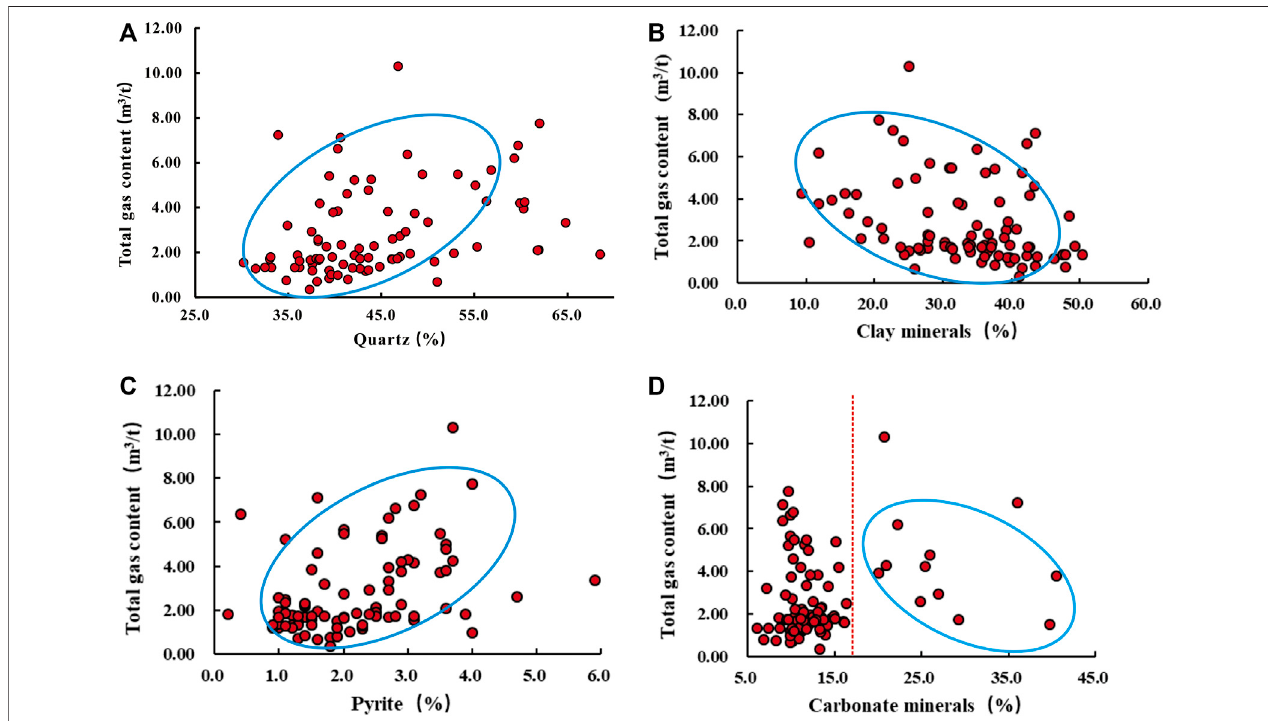
FIGURE 8 | Relationship between the minerals and the total gas contents of the Longmaxi Formation shale in the Changning area. (A) Relationship between the quartz and the total gas contents; (B) Relationship between the clay minerals and the total gas contents; (C) Relationship between the pyrite and the total gas contents; (D) Relationship between the carbonate minerals and the total gas